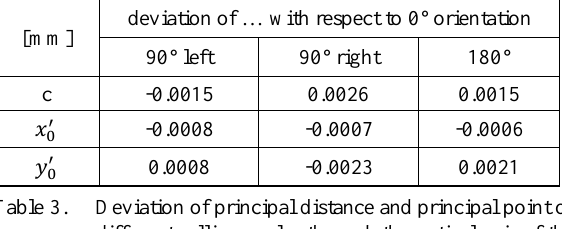
Deviation of principal distance and principal point of different rolling angles through the optical axis of the ALPA 12 FPS add|metric